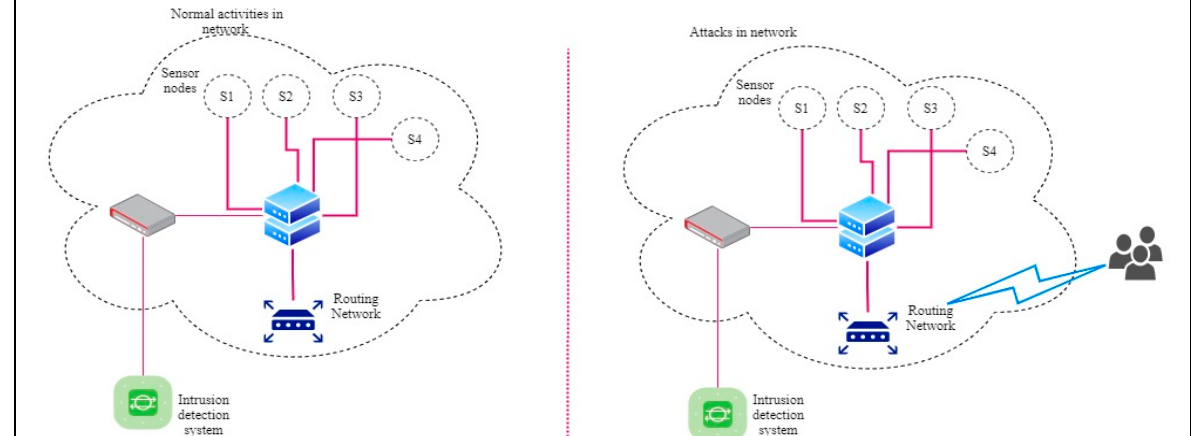
Figure 4. IoT Experimental Structure of Intrusion Detection System.